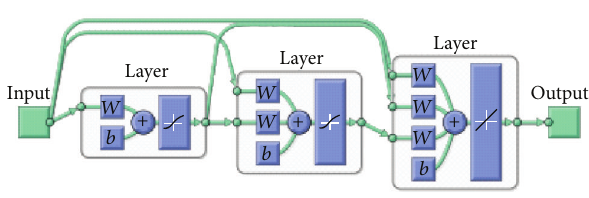
Figure 10: Proposed CFNN architecture for Cu(II) removal system.